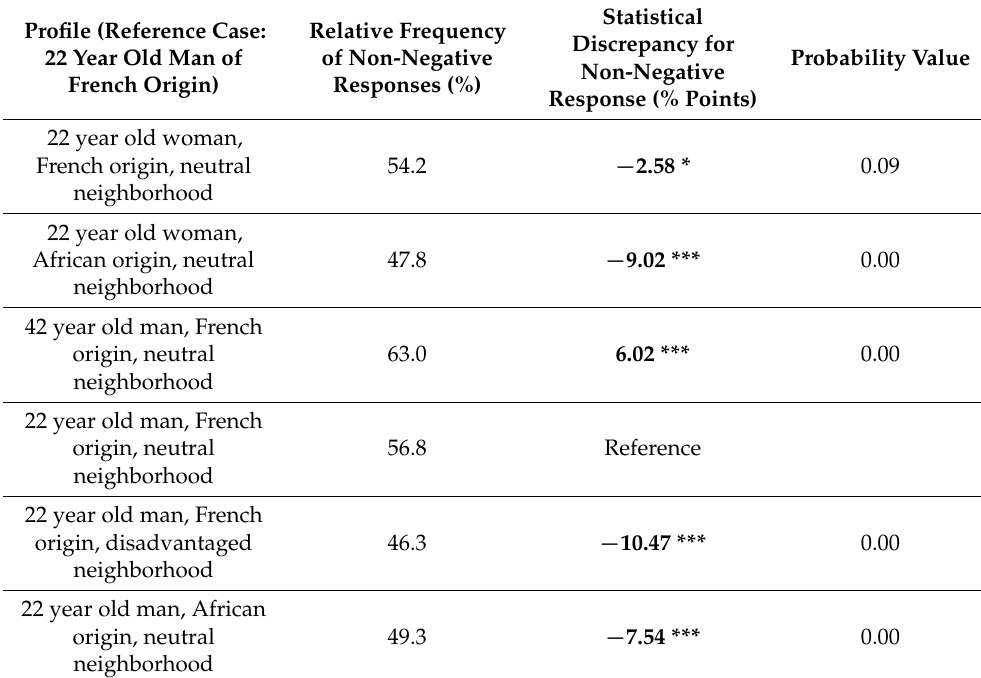
Table 8. Differences in the non-negative response rate relating to requests for travel accommodations (reference profile: 22 year old man, French